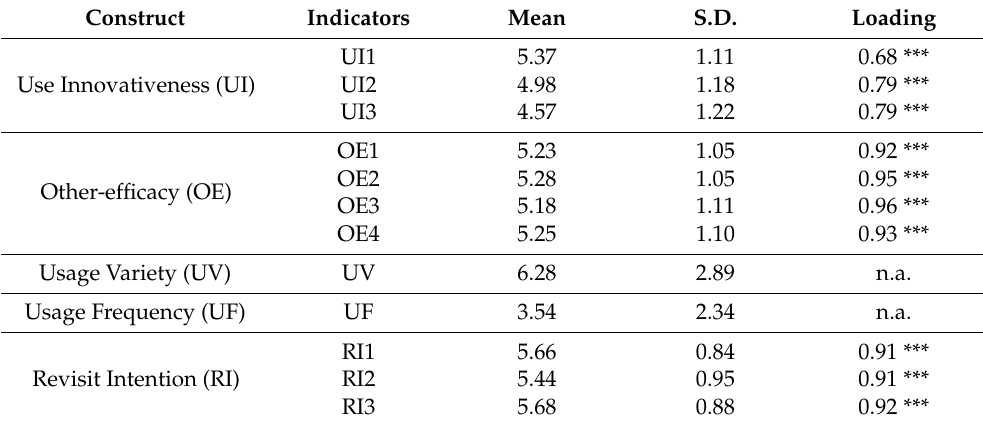
Table 1. Means, standard deviations, and standardized loadings of manifest variables.